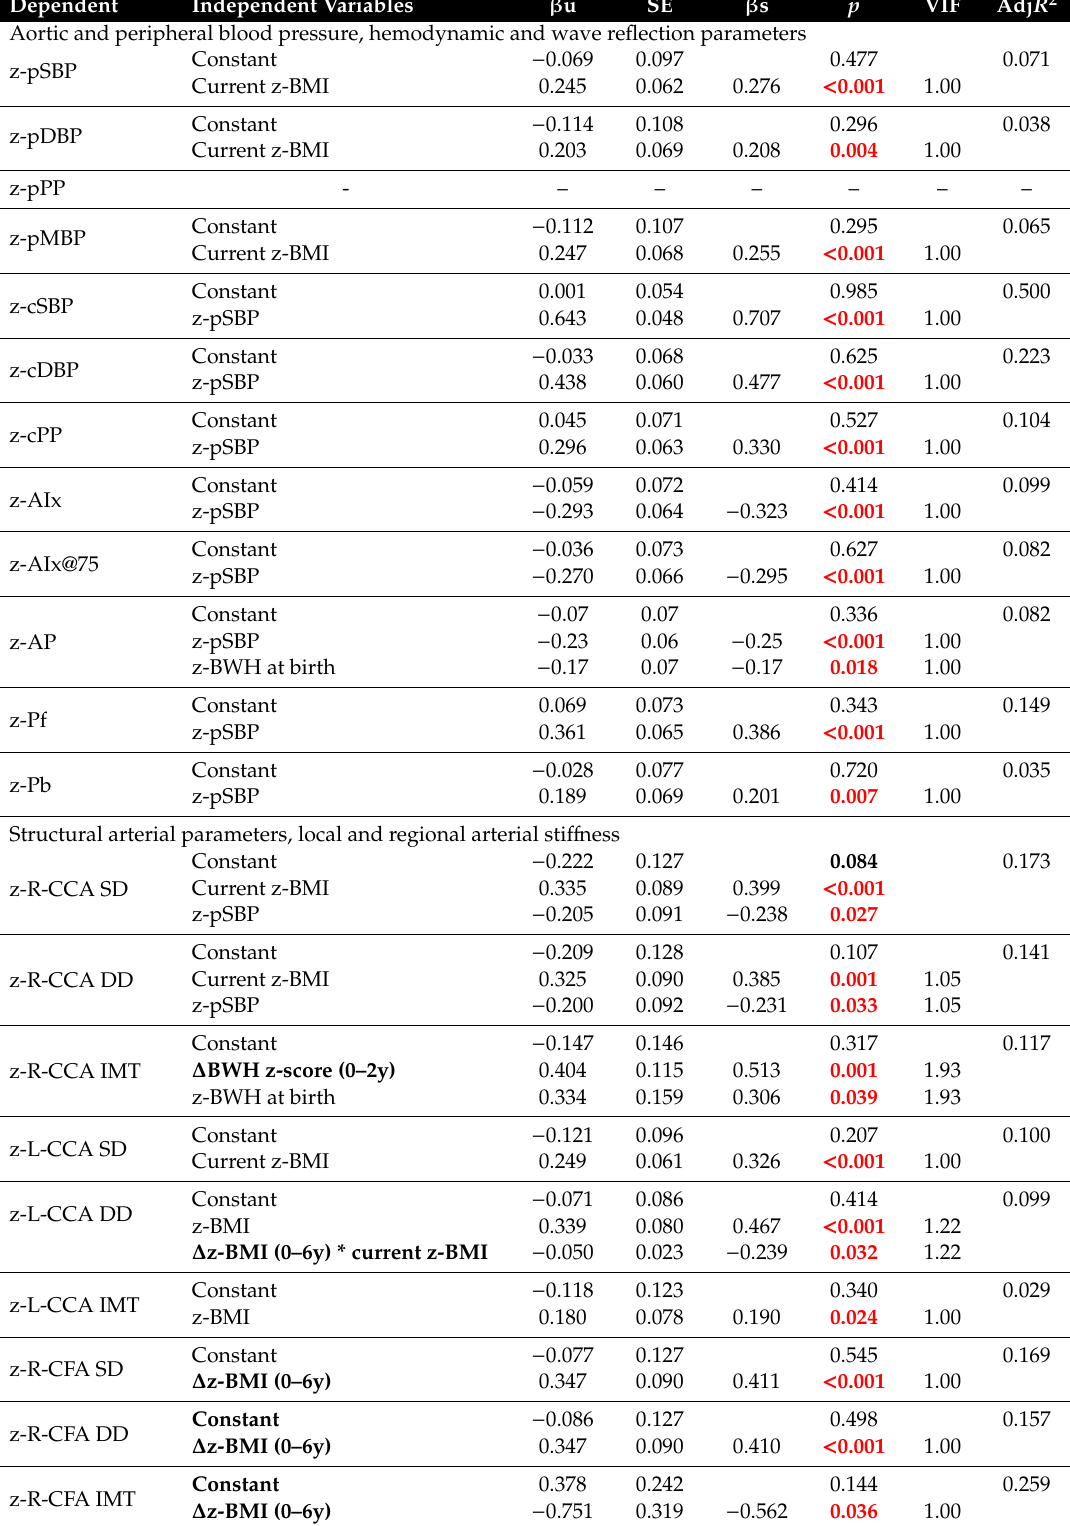
Table 9. Multiple regression analysis between CVvariables (dependent) and anthropometric and CRFsvariables (independent) in children cohort ( n =